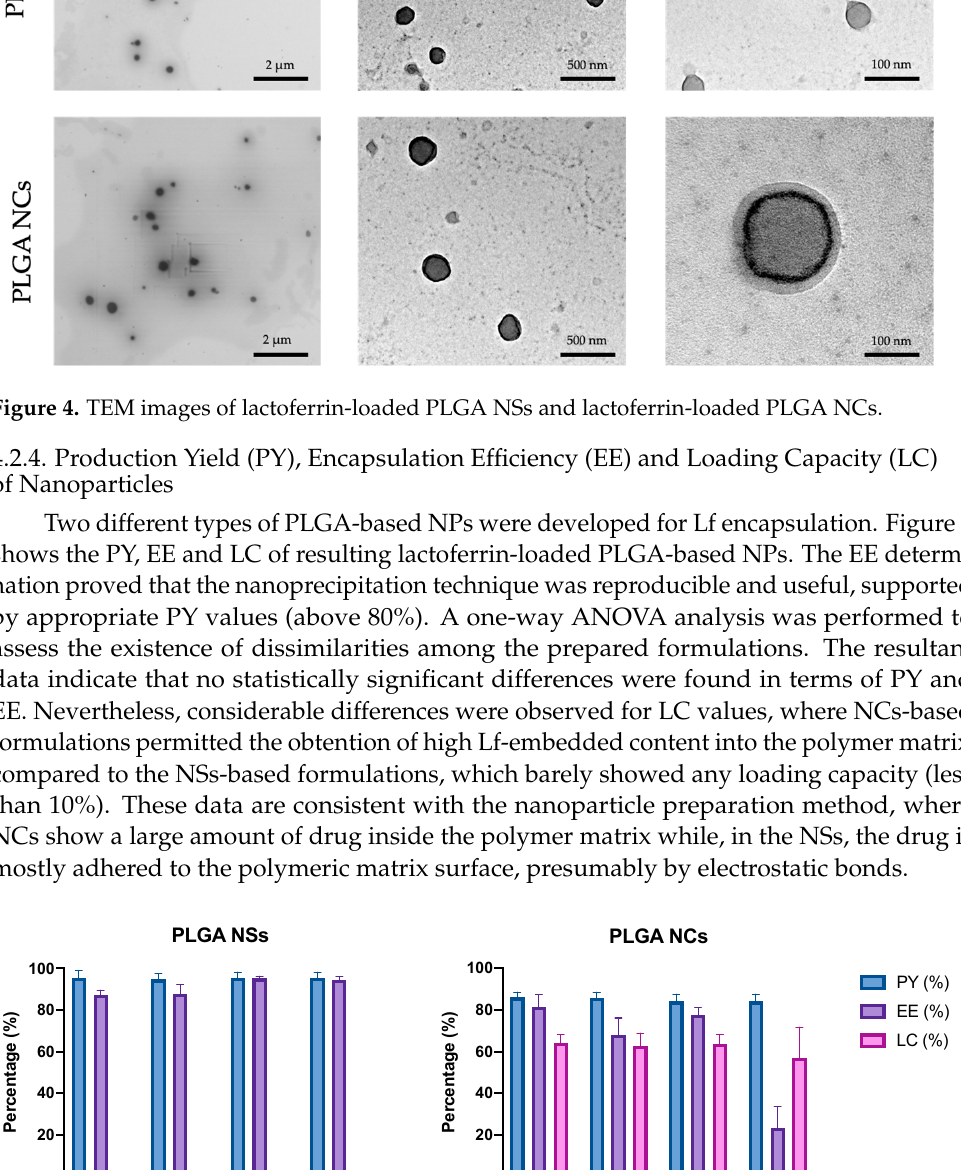
Figure 4. TEM images of lactoferrin-loaded PLGA NSs and lactoferrin-loaded PLGA NCs.